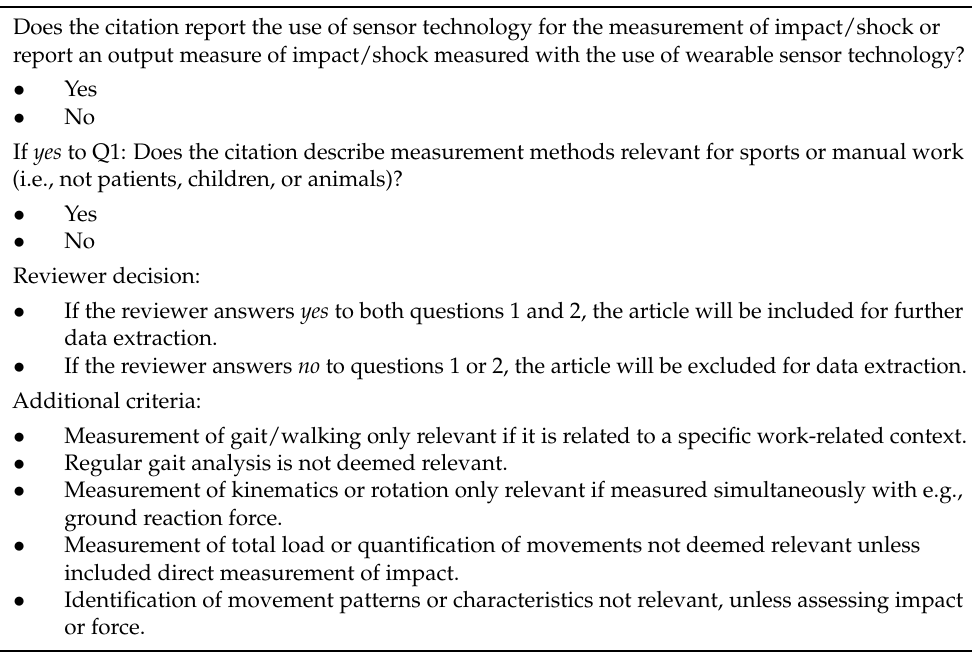
Table A2. Full text screening